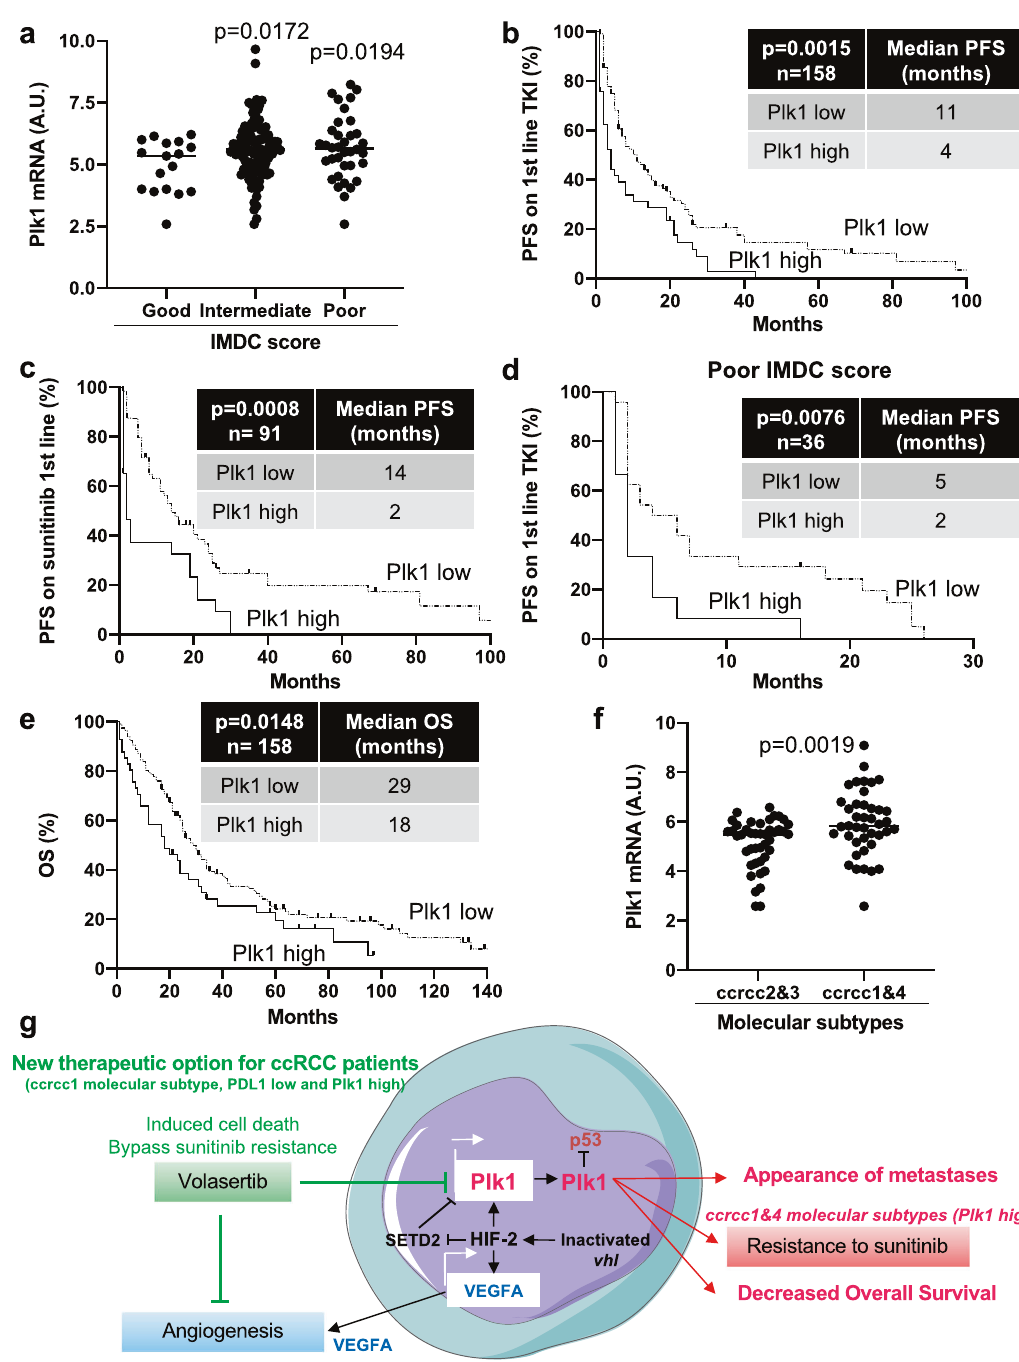
Fig. 6 Plk1 is associated with resistance to fi st-line VEGFR-TKI treatment in ccRCC. The tumors of 58 metastatic ccRCC patients were analyzed for the Plk1 mRNA level. a The levels of Plk1 mRNA in tumors from patients with a good, intermediate, and poor IMDC score were compared. b – e The levels of Plk1 mRNA in tumors of 58 metastatic ccRCC patients treated with VEGFR-TKI in the fi rst line correlated with PFS ( b ) or with OS ( e ). The levels of Plk1 mRNA in tumors of 27 metastatic ccRCC patients treated with sunitinib in the fi rst line correlated with PFS ( c ). The levels of Plk1 mRNA in tumors from patients with an intermediate IMDC score correlated with PFS ( d ). f The levels of Plk1 mRNA in tumors of the ccrcc2&3 and ccrcc1&4 subtypes were compared. The third quartile of Plk1 expression was chosen as the cut-off value. Statistics were determined using an unpaired Student ’ s t test. The Kaplan-Meier method was used to produce survival curves and analyses of censored data were performed using Cox models. Statistical signi fi cance ( p values) is indicated (see Table 3). g The summary diagram of our study describing the phenomenon linking a physical driver of tumor aggressiveness (hypoxia) to a biological determinant of tumor cell proliferation and angiogenesis (Plk1). The link between the two actors is HIF-2, which drives Plk1 gene transcription through a SETD2-dependent mechanism. In addition to its tumor promoting role, Plk1 drives resistance to TKI and appears as a key target for a subgroup of metastatic ccRCC patients in therapeutic